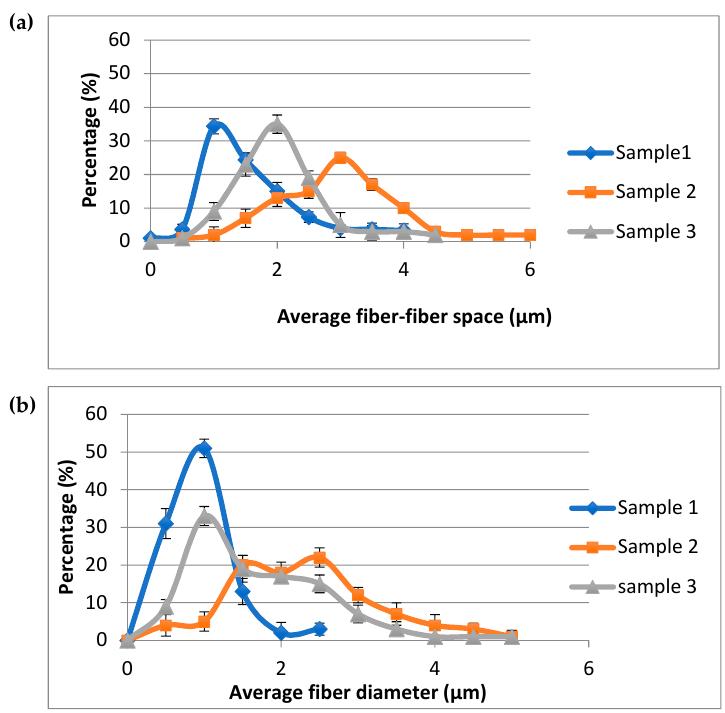
Figure 6. ( a ) Distribution of average fibre–fibre space and ( b ) average fibre diameter of three electrospun scaffolds (Table 1).